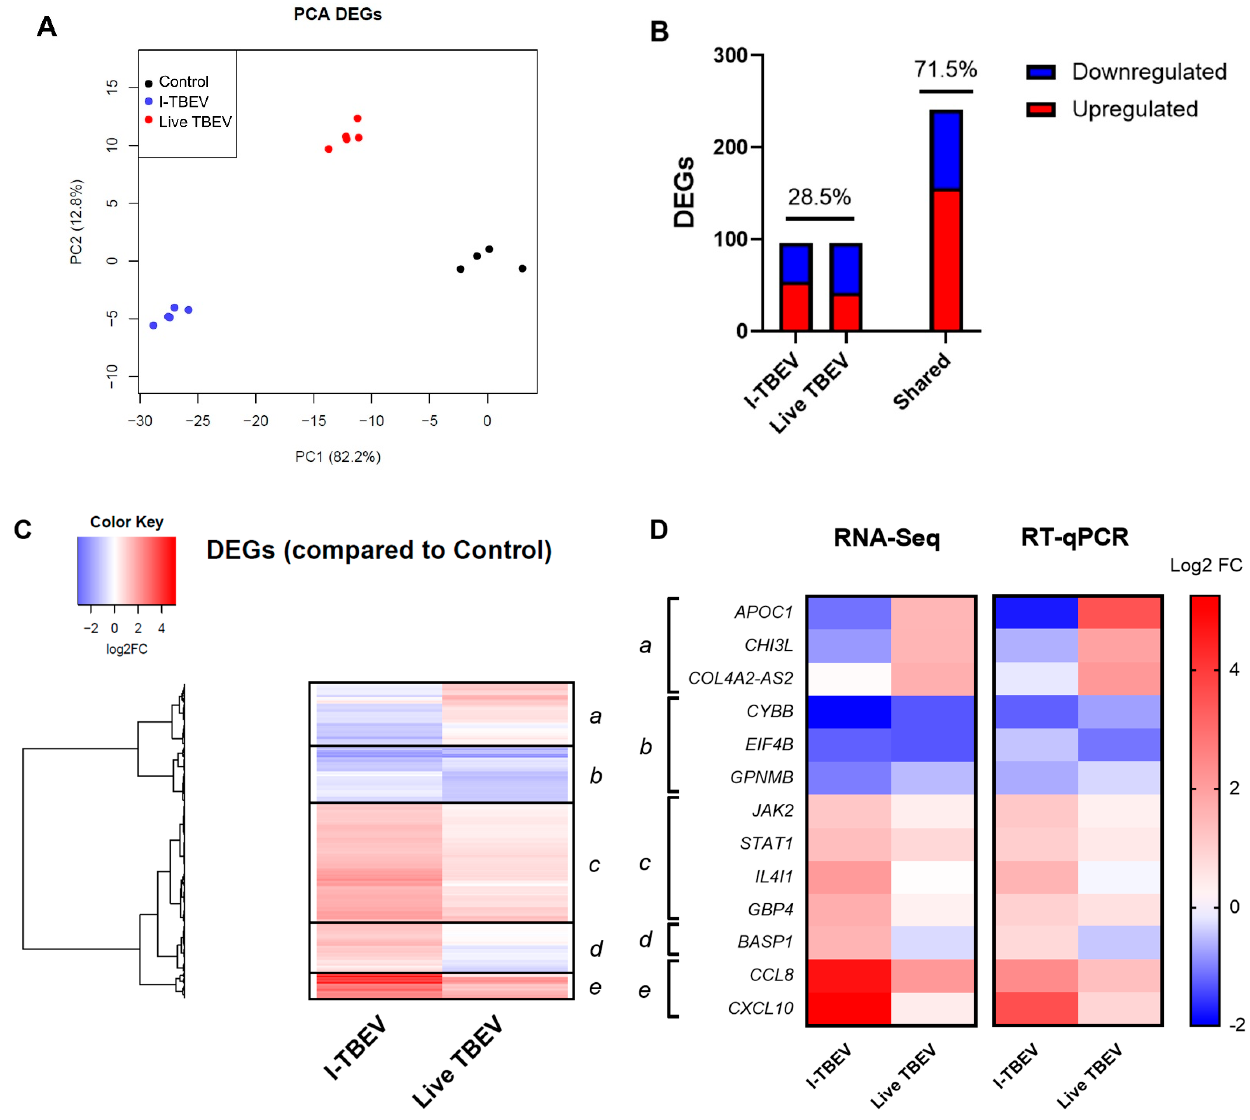
Figure 2. Transcriptional analysis of PBMCs stimulated with I-TBEV and live TBEV (Analysis 2). PBMCs from a healthy donor were stimulated for 24 h with inactivated TBEV (I-TBEV) at a concentration of 0.24 μ g/mL or 48 h with live TBEV at an MOI of 10. After treatment, the cells were lysed and processed for RNA sequencing. ( A ) Principal component analysis based on DEGs. ( B ) Representation of DEGs with distinct or overlapping change in expression in the I-TBEV and live TBEV treatment groups as compared to the control. ( C ) Heatmap showing the FC of differentially expressed genes (DEGs) in the two treatment groups, normalized to the control group (set as FC = 1) and hierarchically clustered. ( D ) Validation of RNA-Seq results by RT- qPCR. The fold change in PBMCs was analyzed in duplicate for each gene and treatment, and was averaged for all 3 donors. Results are shown as heatmap and compared to the RNA sequencing data.